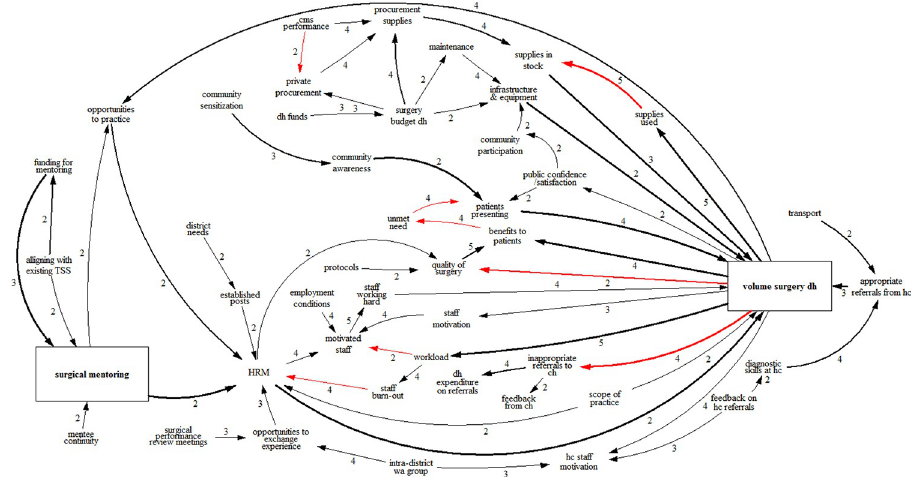
Fig 7. Integrated CLD with only factors that were mentioned in more than one workshop. Black arrows denote positive links, while red arrows denote negative links. The thickness of arrows indicates how often links were mentioned across workshops. The boxes indicate the core factors. The numbers beside arrows indicate the speed of change, with 1 being the slowest and 5 being the fastest. As there are many feedback loops the notation for them has been omitted for